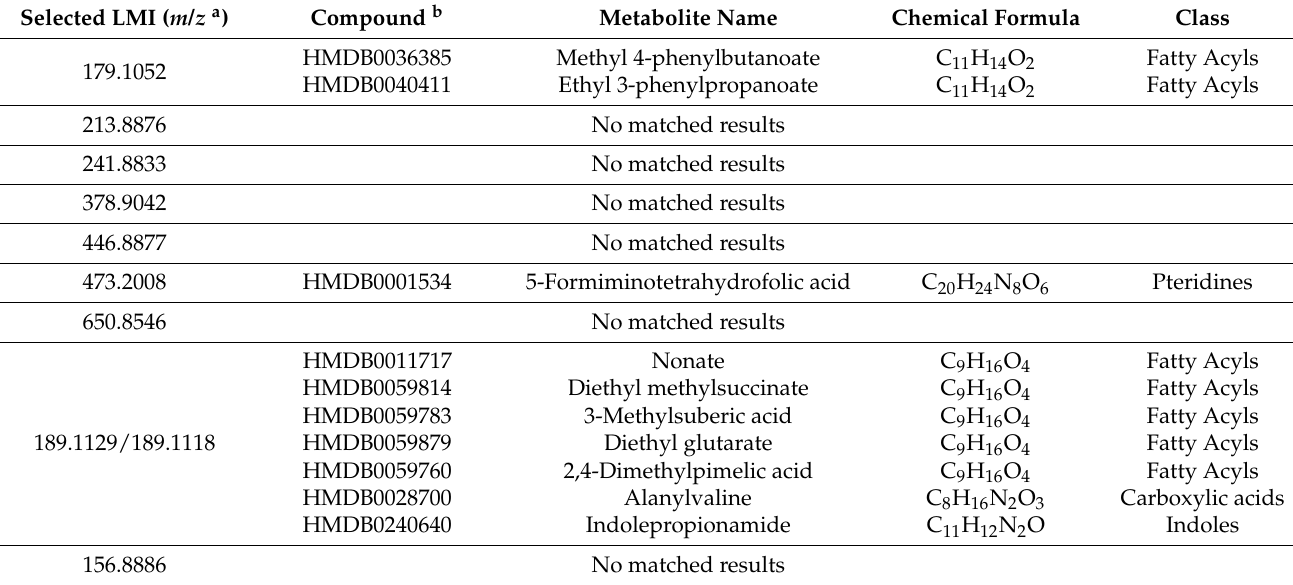
Figure 2. Evaluation of discriminative low mass ions (LMIs) between lumbar and ventricular CSF. ( A ) Volcano plot illustrating significantly discriminative LMIs for each compartment. X-axis: Log 10 (mean abundance of ventricular/mean abundance of lumbar). Y-axis: − Log 10 (paired t- test p -value). LMIs with 2-group t -test p -value < 0.05 are presented in blue or red color dots. An example of highly expressed LMIs in ( B ) lumbar and ( C ) ventricular CSF by comparing paired samples from each patient ( n = 20). Table 3. Top 10 low mass ions increased in the lumbar CSF compared with the paired ventricular CSF. Selected LMI ( m / z a